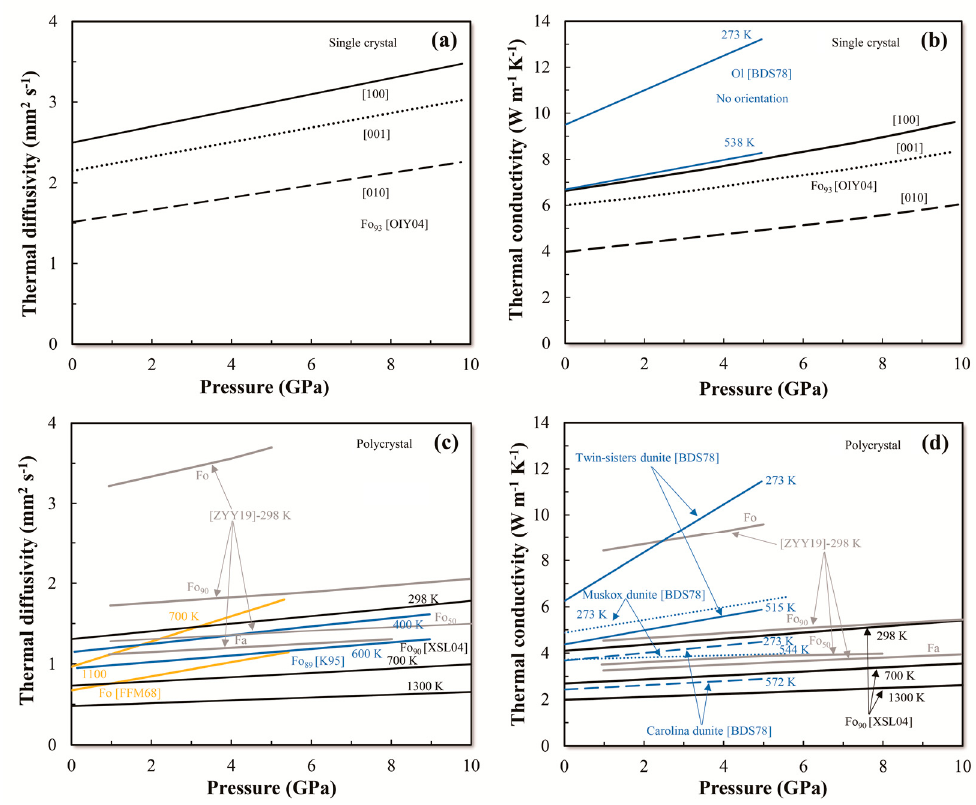
Figure 3. Pressure dependence of D and κ of olivine. ( a ) and ( c ): D . ( b ) and ( d ): κ . Data source: FFM68, Fujisawa et al. [20]; BDS78, Beck et al. [46]; K95, Katsura [38]; OIY04, Osako et al. [24]; XSL04, Xu et al. [22]; ZYY19, Zhang et al. [30].